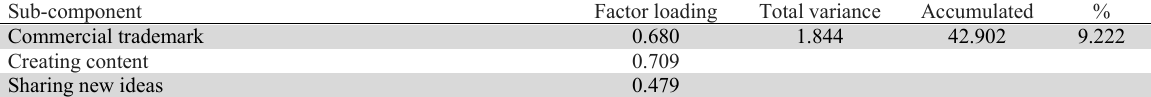
The summary of the sub-component influencing on details of content marketing Sub-component Factor loading Accumulated Commercial trademark